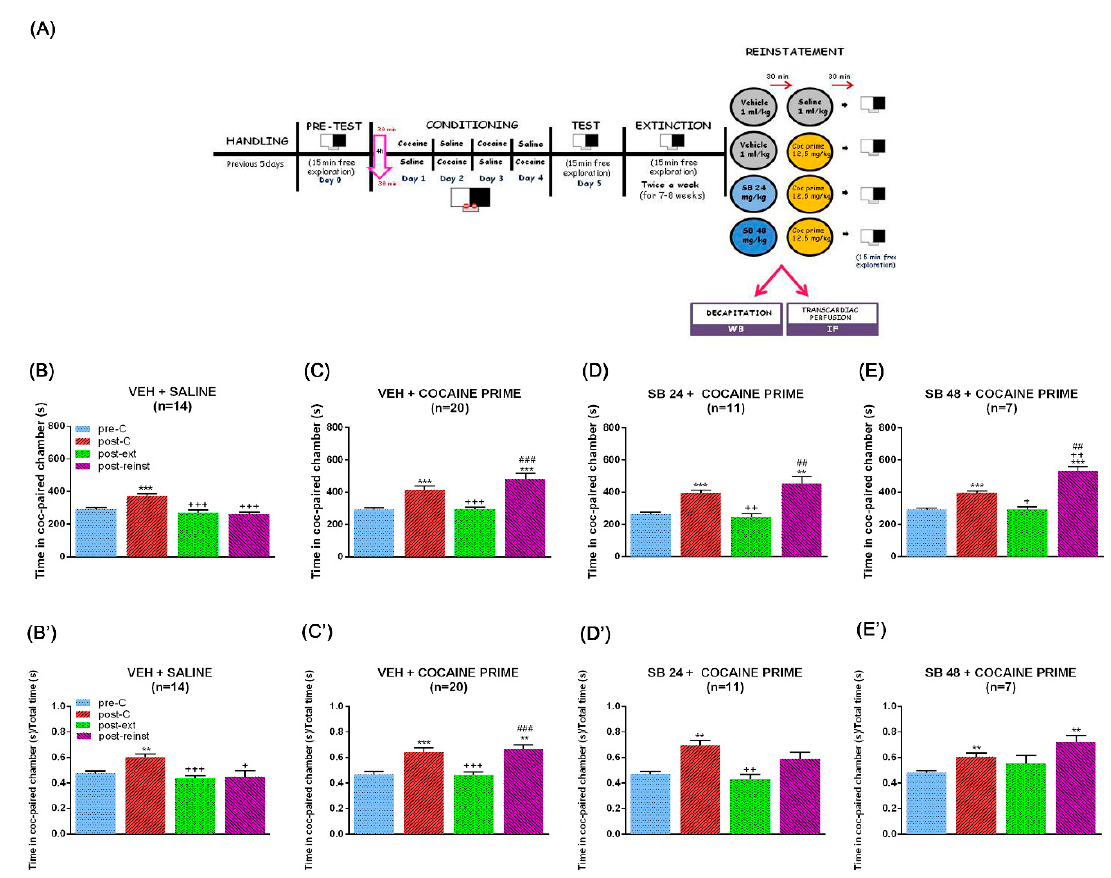
Figure 1. Timeline of the behavioural experimental procedure and effects of selective dopamine type 3 receptor (D3DR) blockade with SB-277011-A (24 or 48 mg/kg i.p.) on the reinstatement of conditioned place preference (CPP) induced by cocaine-priming. ( A ) Schematic representation showing the behavioural procedure. After 5 habituation and handling days, on day 0 animals were placed in the central corridor and allowed to explore the apparatus freely for 15 min. For each mouse, one chamber was randomly chosen to be paired with cocaine and the other chamber with saline. During days 1–4, animals were treated with cocaine and saline (conditioning sessions). The CPP test was conducted on day 5, exactly as in the preconditioning phase. Once achieved the criterion of extinction, a second session was performed 48 h later in order to confirm extinction. One day after the second extinction test, different groups of mice received vehicle or SB-277011-A (24 or 48 mg/kg i.p.) 30 min before saline or a cocaine prime dose. Fifteen min after saline or cocaine prime, mice were allowed to explore the apparatus freely (reinstatement test) and were sacrificed 15 min later, immediately after the reinstatement. ( B – E ) show the mean preference time spent in the cocaine-paired chamber during the pre-conditioning (pre-C), post-conditioning (post-C), post-extinction (post-ext) and reinstatement (post-reinst) in male mice pretreated with ve- hicle plus saline ( B ), vehicle plus cocaine prime ( C )m and SB-277011-A (24 or 48 mg/kg i.p.) plus cocaine prime (( D , E ), respectively). ( B’ – E’ ) show the mean ratio of preference between the time spent in the cocaine-paired chamber and the total time spent in both chambers during the pre-C, post-C, post-ext, and reinst tests in male mice pretreated with vehicle plus saline ( B’ ), vehicle plus cocaine prime ( C’ ), and SB-277011-A (24 or 48 mg/kg i.p.) plus cocaine prime (( D’ , E’ ), respec- tively).** p < 0.01, *** p < 0.001 vs. pre-C; + p < 0.05, ++ p < 0.01, +++ p < 0.001 vs. post-C; ## p < 0.01, ### p < 0.001 vs. post-ext. Each bar corresponds to mean ± standard error of the mean (n = 7–20 per group). Additionally, extinguished CPP can be firmly reinstated by exposure to stressful stimuli such as social defeat [31]. One-way ANOVA with repeated measures revealed sig- nificant differences between treatments for all the sets of animals (F (1.73,25.99) = 30.81, p < 0.001 for veh + not defeat; F (2.24,49.25) = 40.09, p < 0.001 for veh + social defeat; F (1.30,16.90) = 12.22, p < 0.01 for SB 12 + social defeat; F (1.84,38.64) = 18.28, p < 0.001 for SB 24 + social defeat). The Bonferroni test showed that, as opposed to mice that underwent